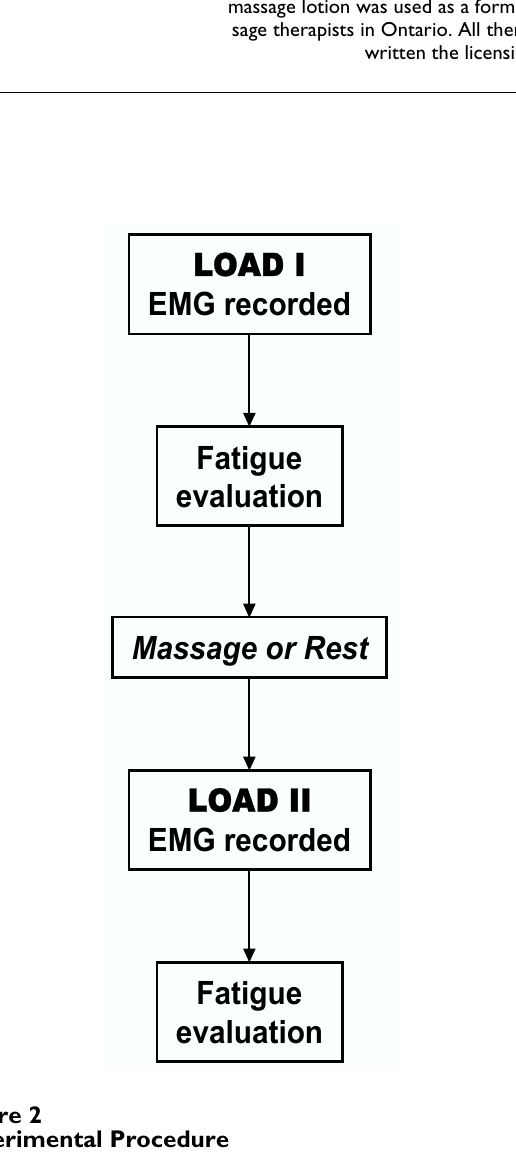
Table 1: Description of the Intervention Rest The subject rested on the treatment table in the prone position for 5 minutes. Massage